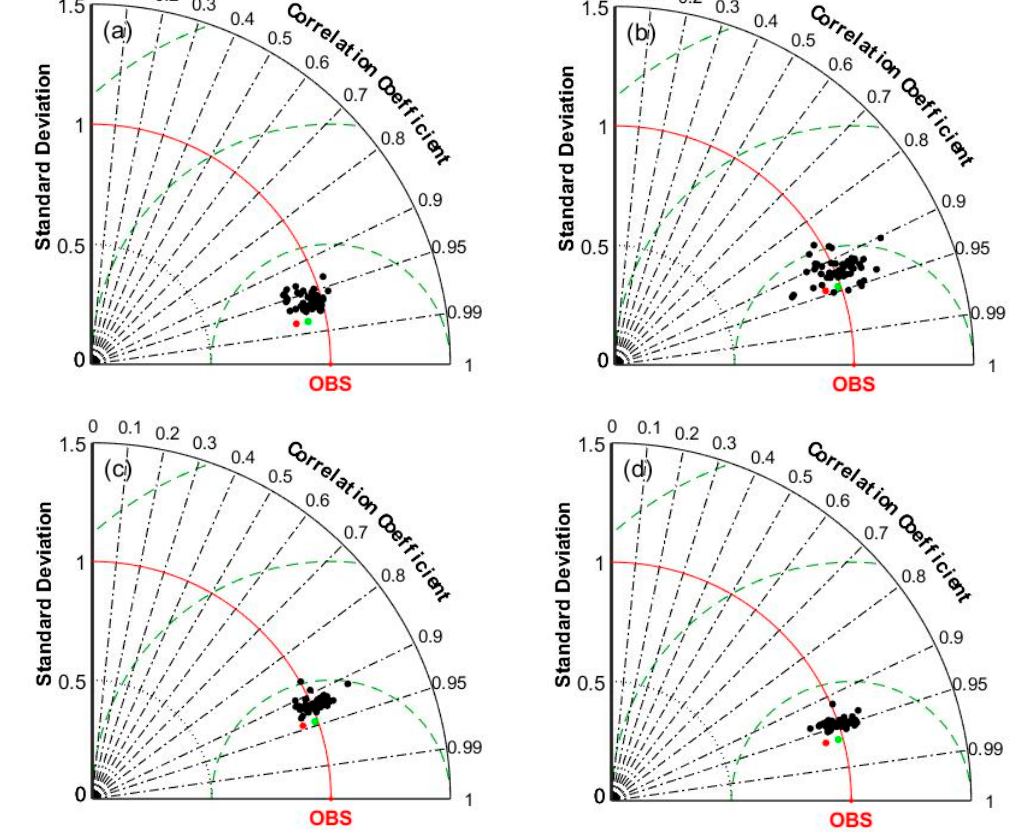
Figure 4. Taylor diagrams of the monthly SULR measurements and MME estimates for BSRN ( a ), SURFRAD ( b ), FLUXNET ( c ), and all 133 sites ( d ). The 51 CMIP6 GCMs, the simple model averaging (SMA) method, and the BMA method are represented by black, green, and red dots, respectively.